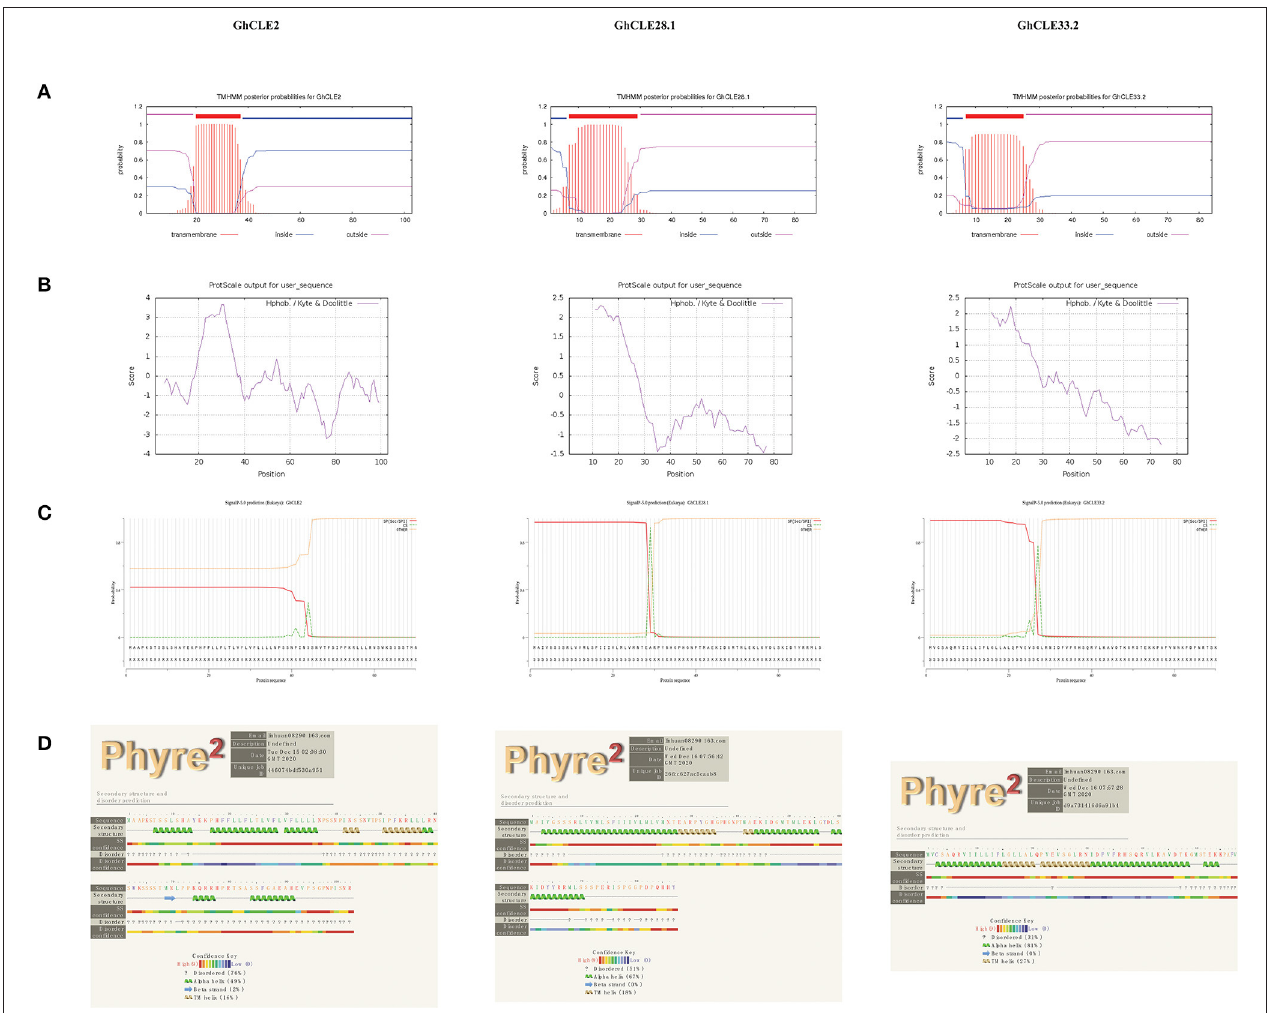
FIGURE 7 | (A–D) Respectively represent transmembrane structure characteristics, hydrophobicity/hydrophilicity, signal peptides, and secondary structure of GhCLE2, GhCLE28.1, and GhCLE33.2.